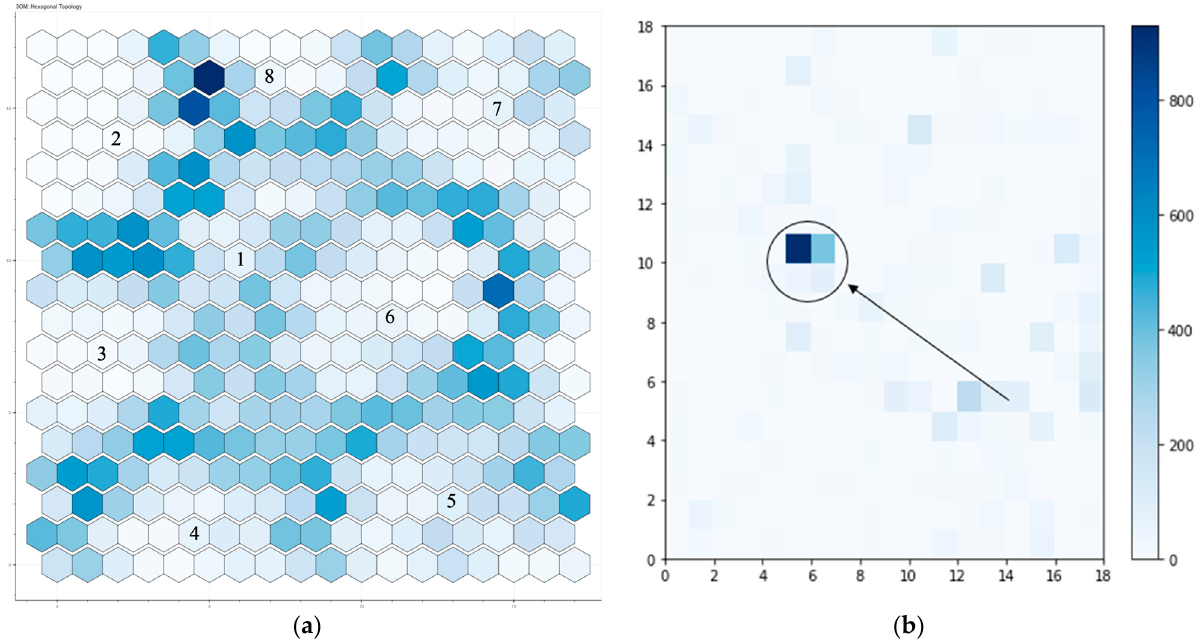
Figure 9. SOM Colour map: ( a ) U-Matrix Colour Map; ( b ) activation response map.